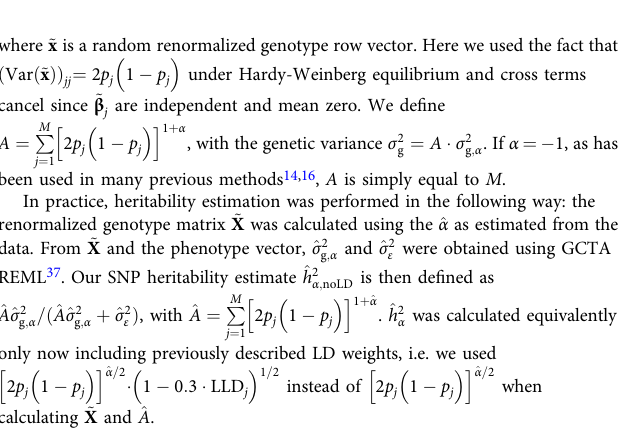
Figure 4, panel (e)), and shape parameters of k = 0.125 and 0.25 which includes the range of plausible values derived by ref. 24 . In the analyses reported